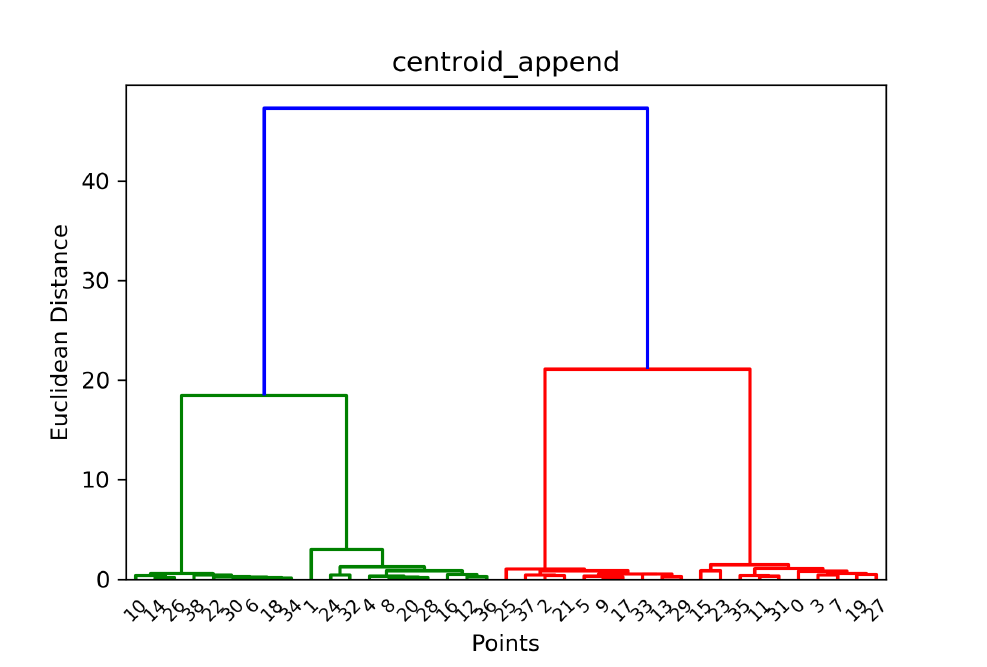
Figure 7. Dendrogram of centroids.